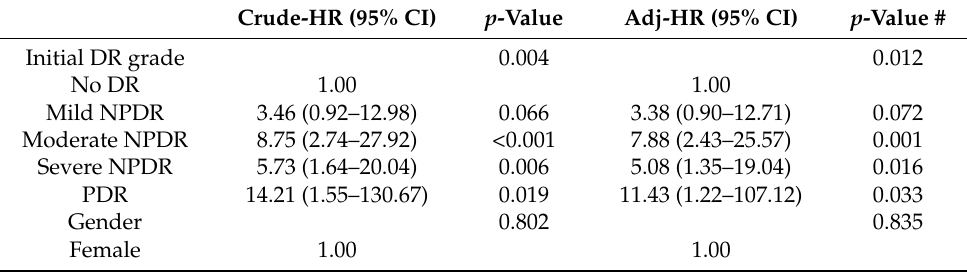
Table 5. The risk of progression to CKD before the end of the study among patients without CKD